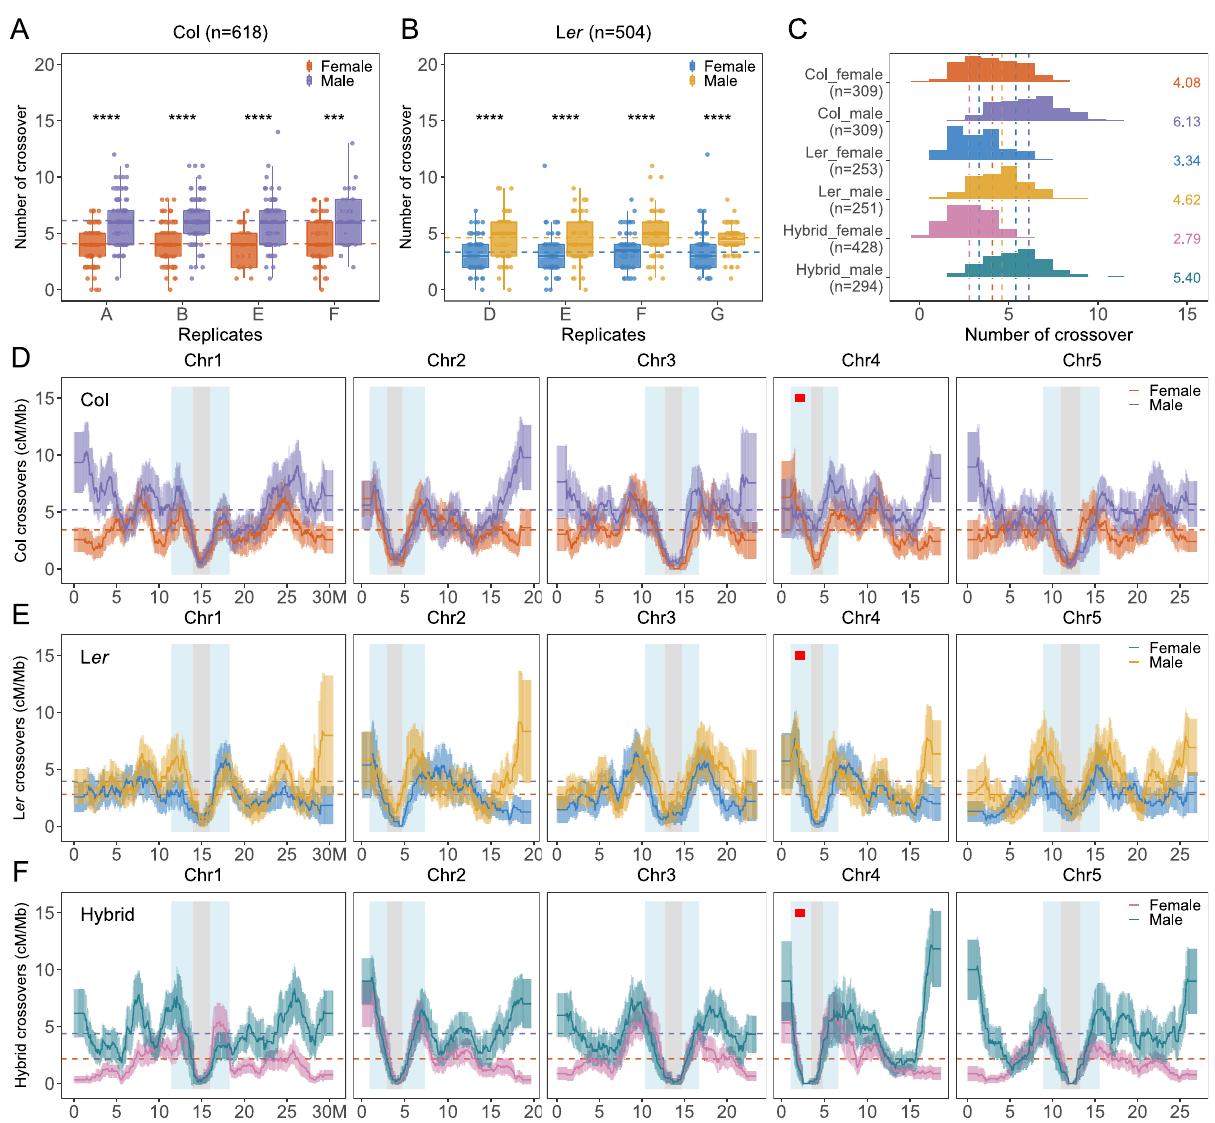
Fig. 2 Analysis of female and male COs in Col, L er , and F1 hybrid populations. A , B The numbers of COs per gamete in each replicate population of Col and L er , respectively. Each letter corresponds to one F1* plant (Fig. 1). The two-sided Mann – Whitney test was used to evaluate the differences in CO numbers between female and male meiosis. The p values for Col replicate A , B , E , F are 4.9e − 12, 2.5e − 12, 4.7e − 06 and 1.9e − 04, respectively. The p values for L er replicate D – G are 5.6e − 06, 6.7e − 05, 6.8e − 05 and 2.6e − 05, respectively. In the boxplot, the centre line indicates median, the bounds of box indicate 25th and 75th percentiles, the whiskers indicate 1.5 * IQR (IQR: the distance between the fi rst and third quartiles). C Distribution of CO number per gamete in female and male meiosis of Col, L er and F1 hybrids. The mean number of COs are colour-coded and indicated by dashed lines. The sample sizes are indicated in parentheses. D – F The chromosomal distribution (sliding window-based, window size 2 Mb, step size 50 kb) of COs in female and male meiosis of Col, L er , and F1 hybrids, with 90% con fi dence interval. The genome-wide mean level of recombination is shown with dashed lines. The pericentromeric and centromeric regions are indicated by grey and blue shading, separately. The ~1.2 Mb inversion between Col and L er on chromosome 4 is indicated by a red bar. Source Data are provided as a Source Data fi